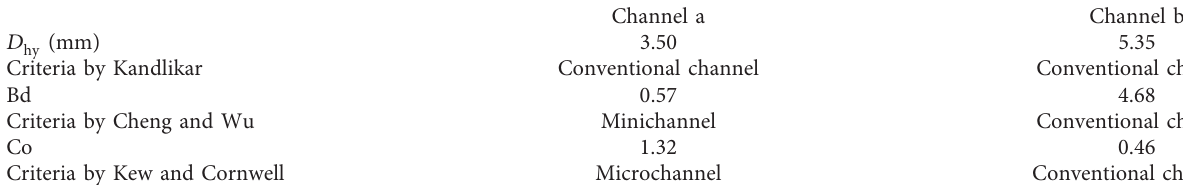
Table 4: Three identification methods of two channels.